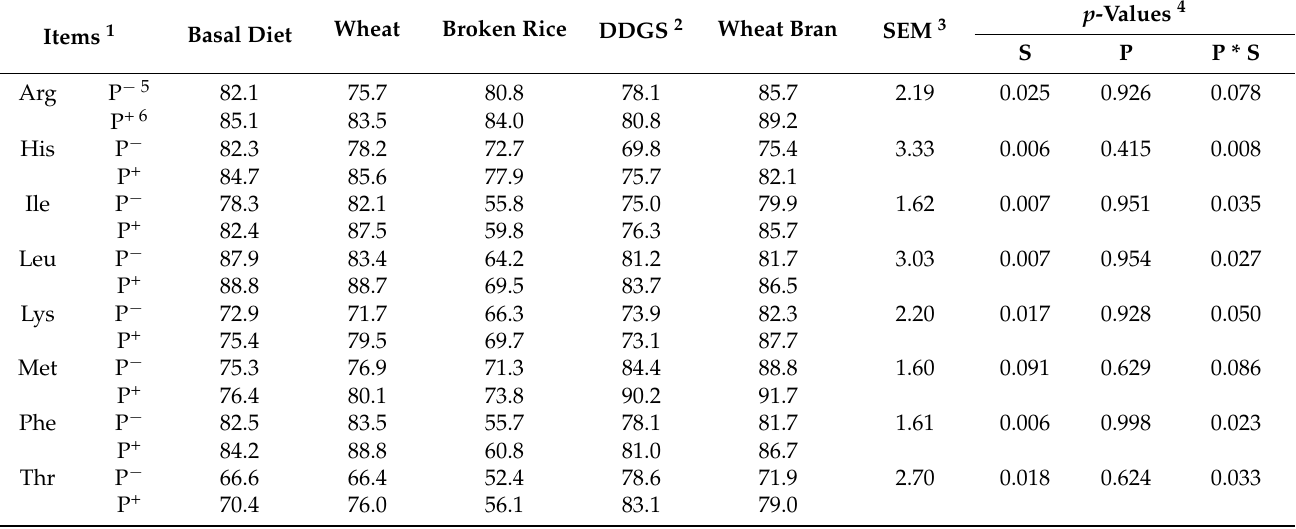
Table 6. Effect of diet supplemented with phytase on apparent ileal digestibility of amino acids in